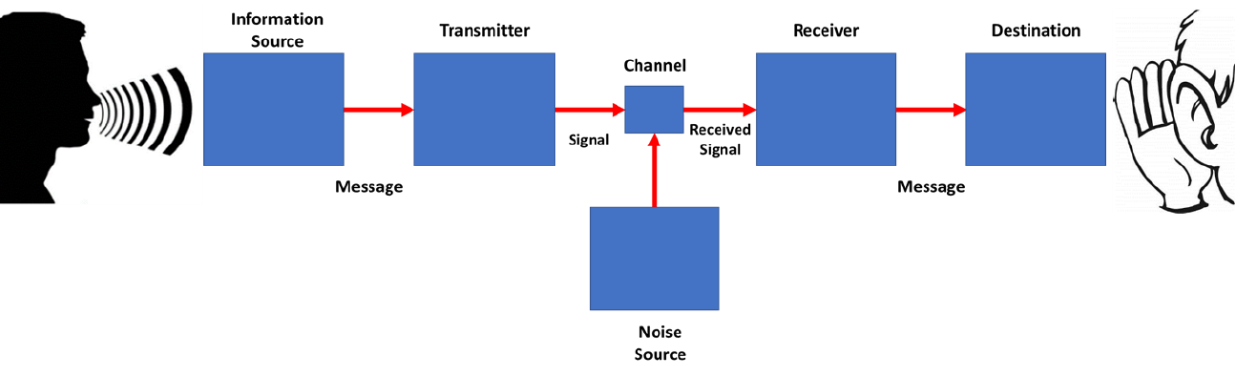
Figure 2. Schematic of a system of communication.